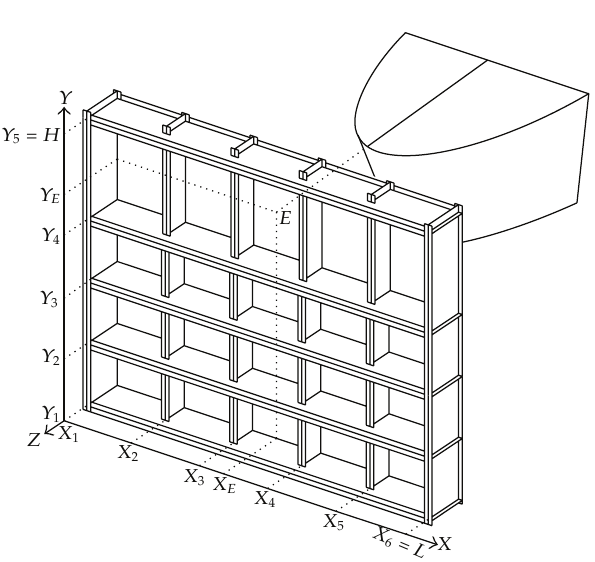
Figure 5: Position of the resistance elements and of the impact